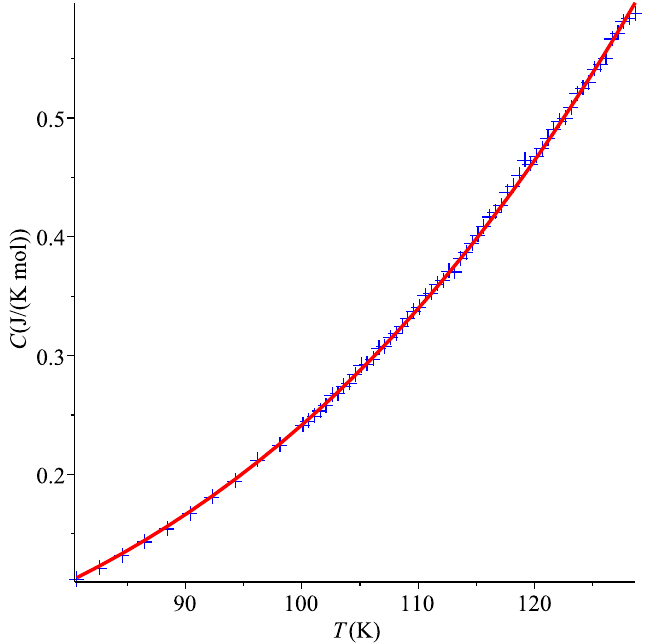
Figure 5. QLT behaviour of the specific heat of natural diamond, unpublished data for Ref. 47